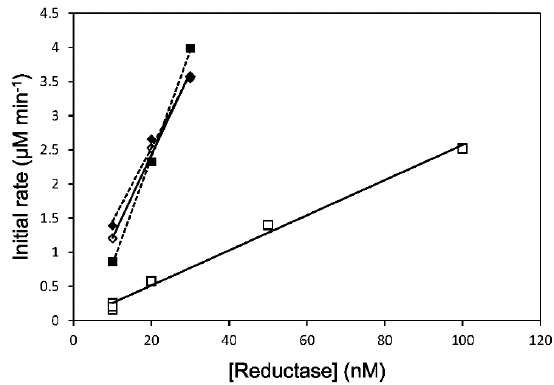
Figure 3. Rate of heme reduction in heme – rHO-1 in the NADPH – rCPR (diamonds) or NADPH – 147CC514 systems (squares). The initial reduction rates of ferric heme – rHO-1 in the presence of rCPR or 147CC514 after the addition of NADPH were recorded under CO-saturated conditions. The results obtained using DTT-treated reductases are plotted as filled symbols and dashed lines. A representative example of the multiple measurements performed is displayed. See Methods for details.